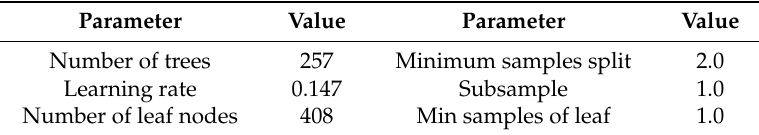
Table 3. The important parameters setting of the GBDT